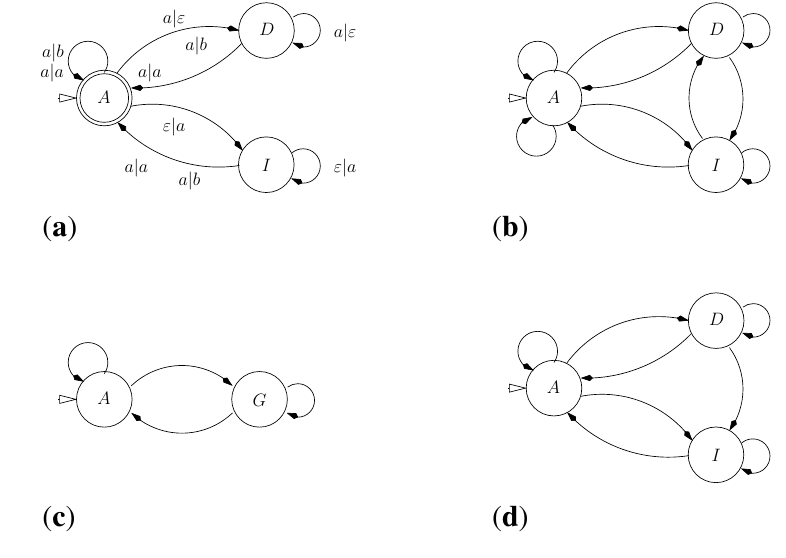
Figure 2. ( a ) Finite State Automaton for alignment with affine gap weights (source [20]); ( b ) Dependency graph for the grammar A FFI ; ( c ) for the grammar A FFI O SCI ; ( d ) and for the grammar A FFI T RACE . The start state/axiom symbol is marked by an